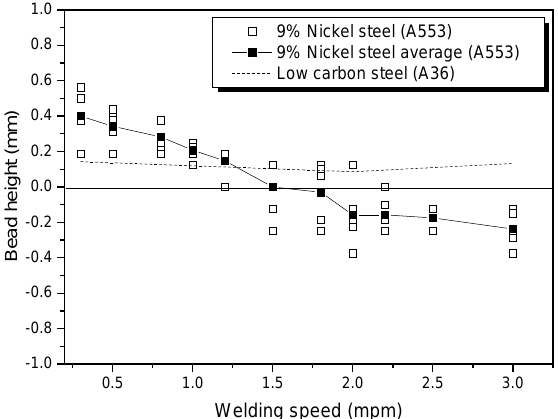
Figure 13. Height fluctuation of surface beads, according to welding speed.